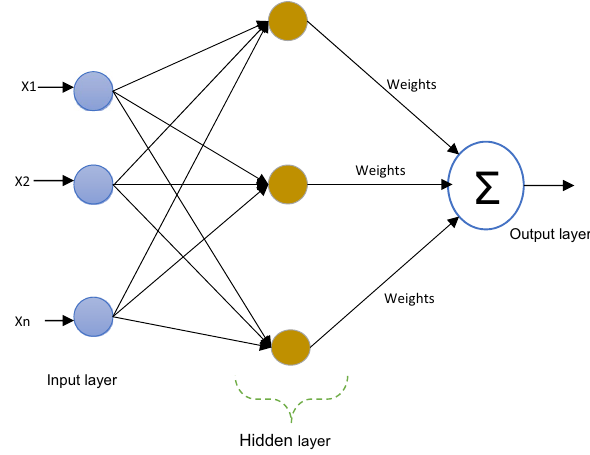
Figure 5. Architecture of